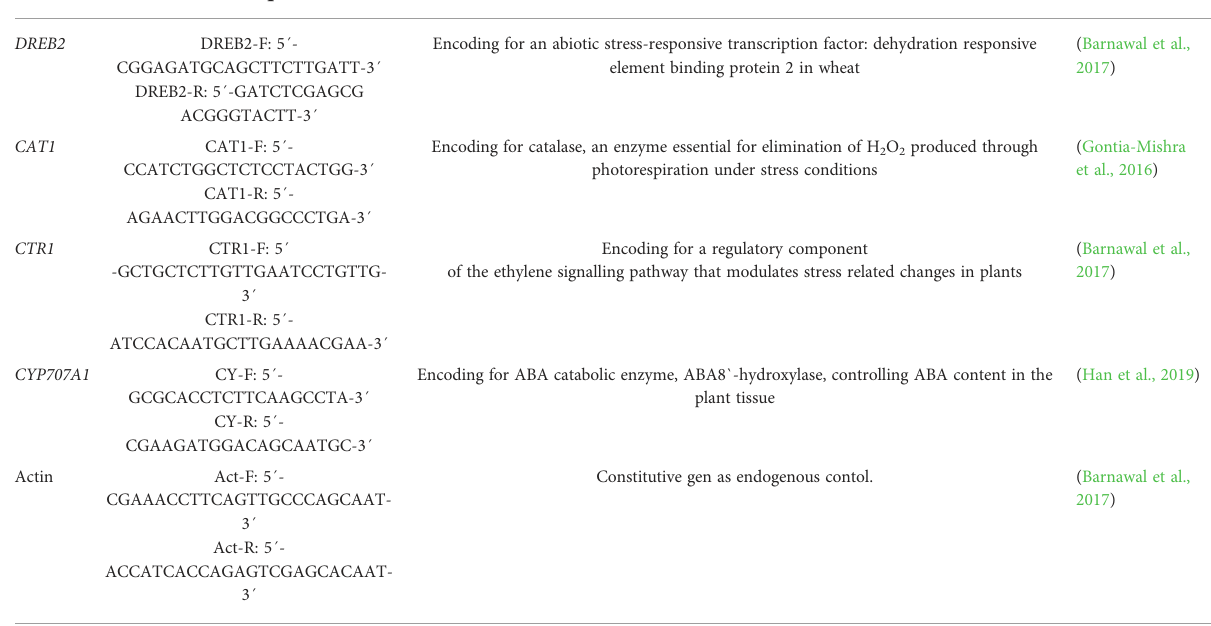
TABLE 1 List of genes and primers used in qRT-PCR. Primer